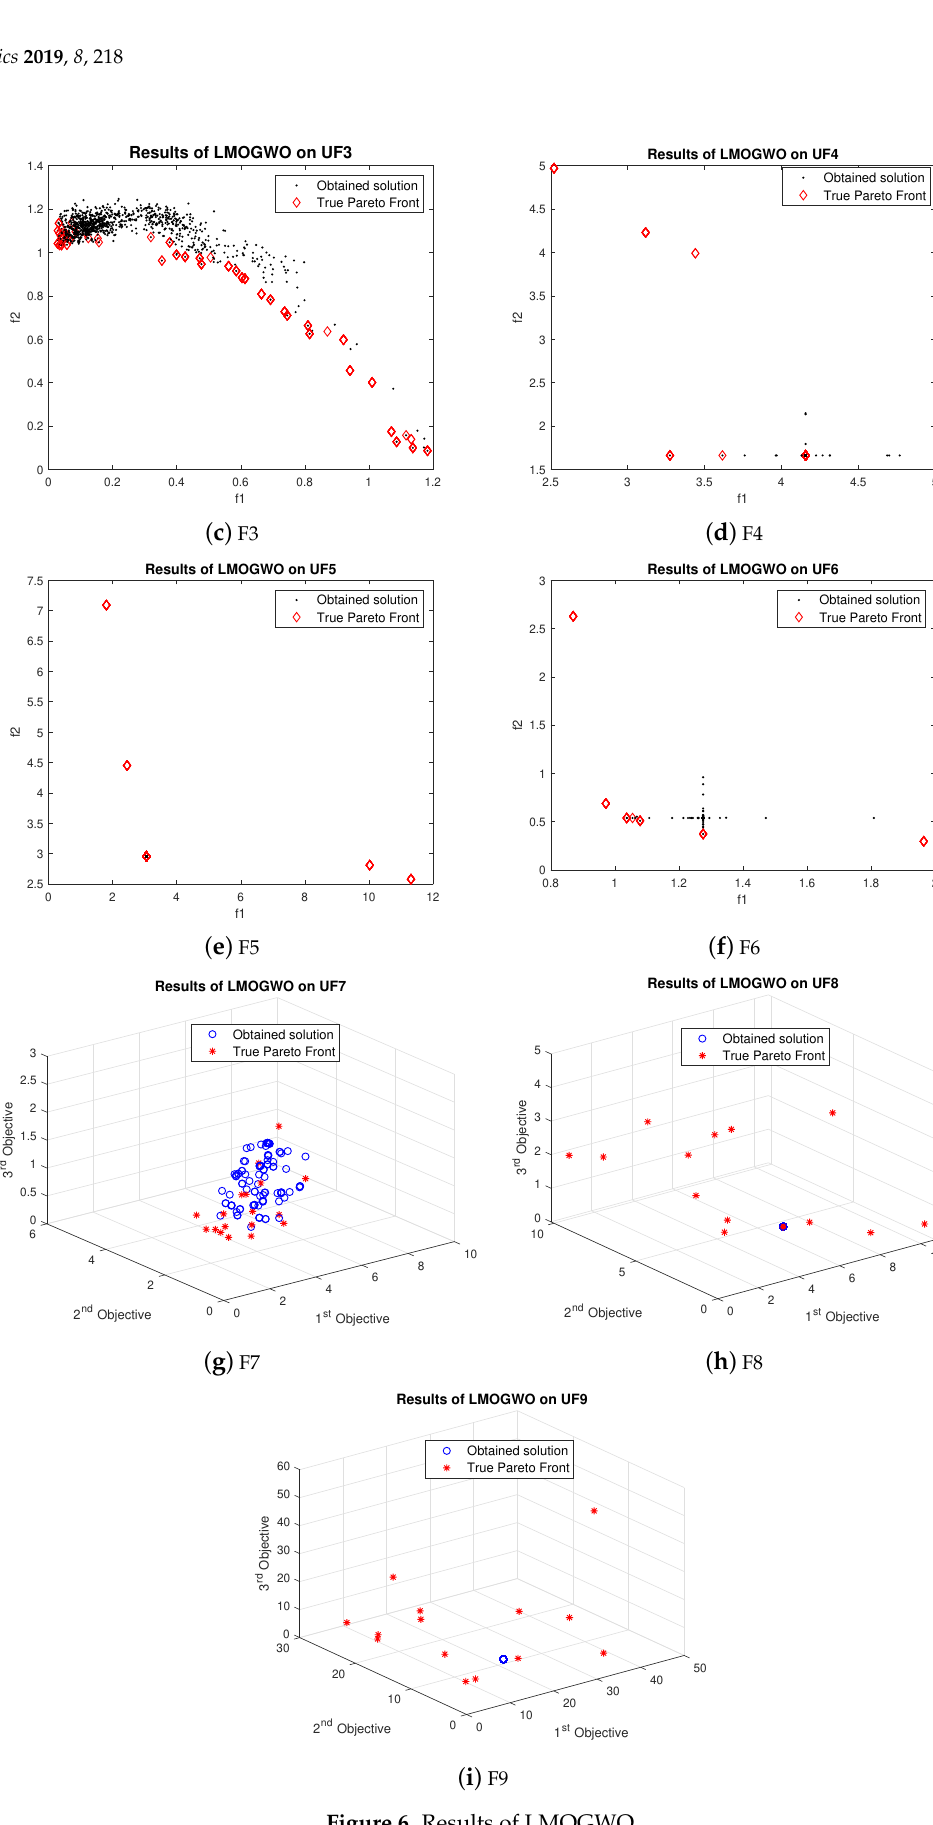
Figure 6. Results of